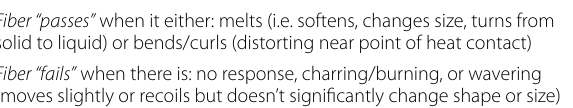
Table 1 Criteria for performing the hot needle test (provided to participants in HNT